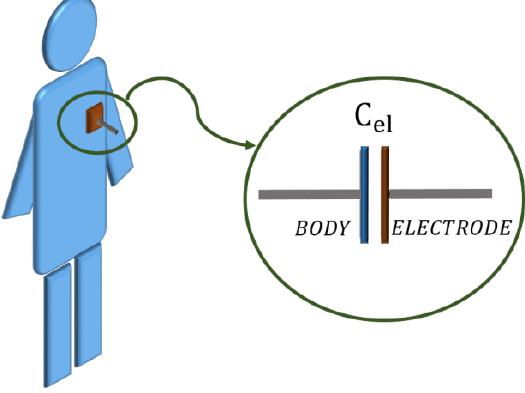
Figure 2. Electrode positioning on the human body.